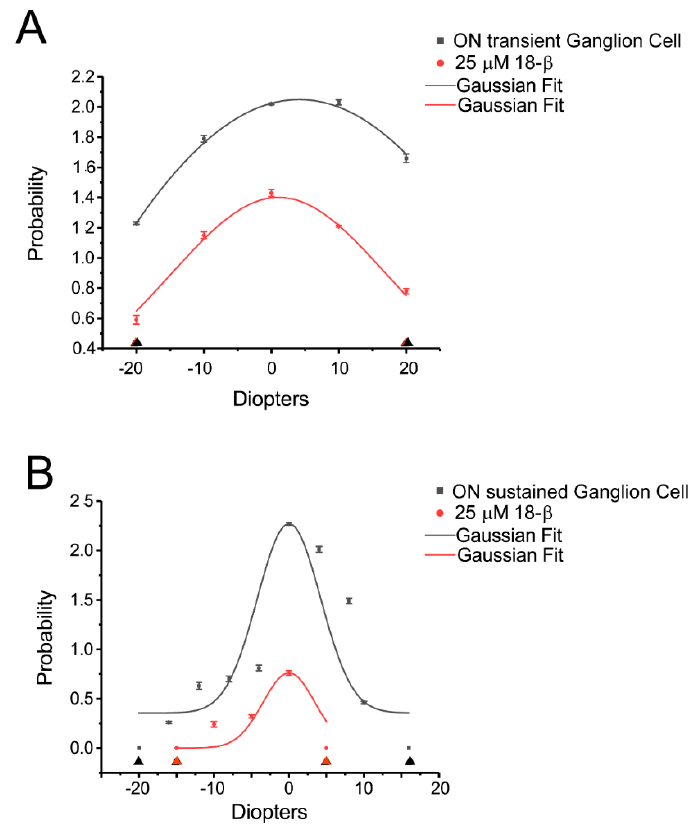
Figure 8. ON alpha RGCs showed decreased responses to defocused image after gap junction blocker application. A : ON alpha transient RGCs showed a significantly decreased response (the probability of spikes) to plus and minus defocused images two minutes after gap junction antagonist, 25 µ M 18- β application. The cell showed no response to plus and minus defocused images above 20D (black and red triangle). B : ON alpha sustained RGCs showed no response to plus and minus defocused images at + 16D and -20D (black triangle). Five minutes after 25 µ M 18- β application, the cells showed no response to defocused image at + 5D and − 15D (red